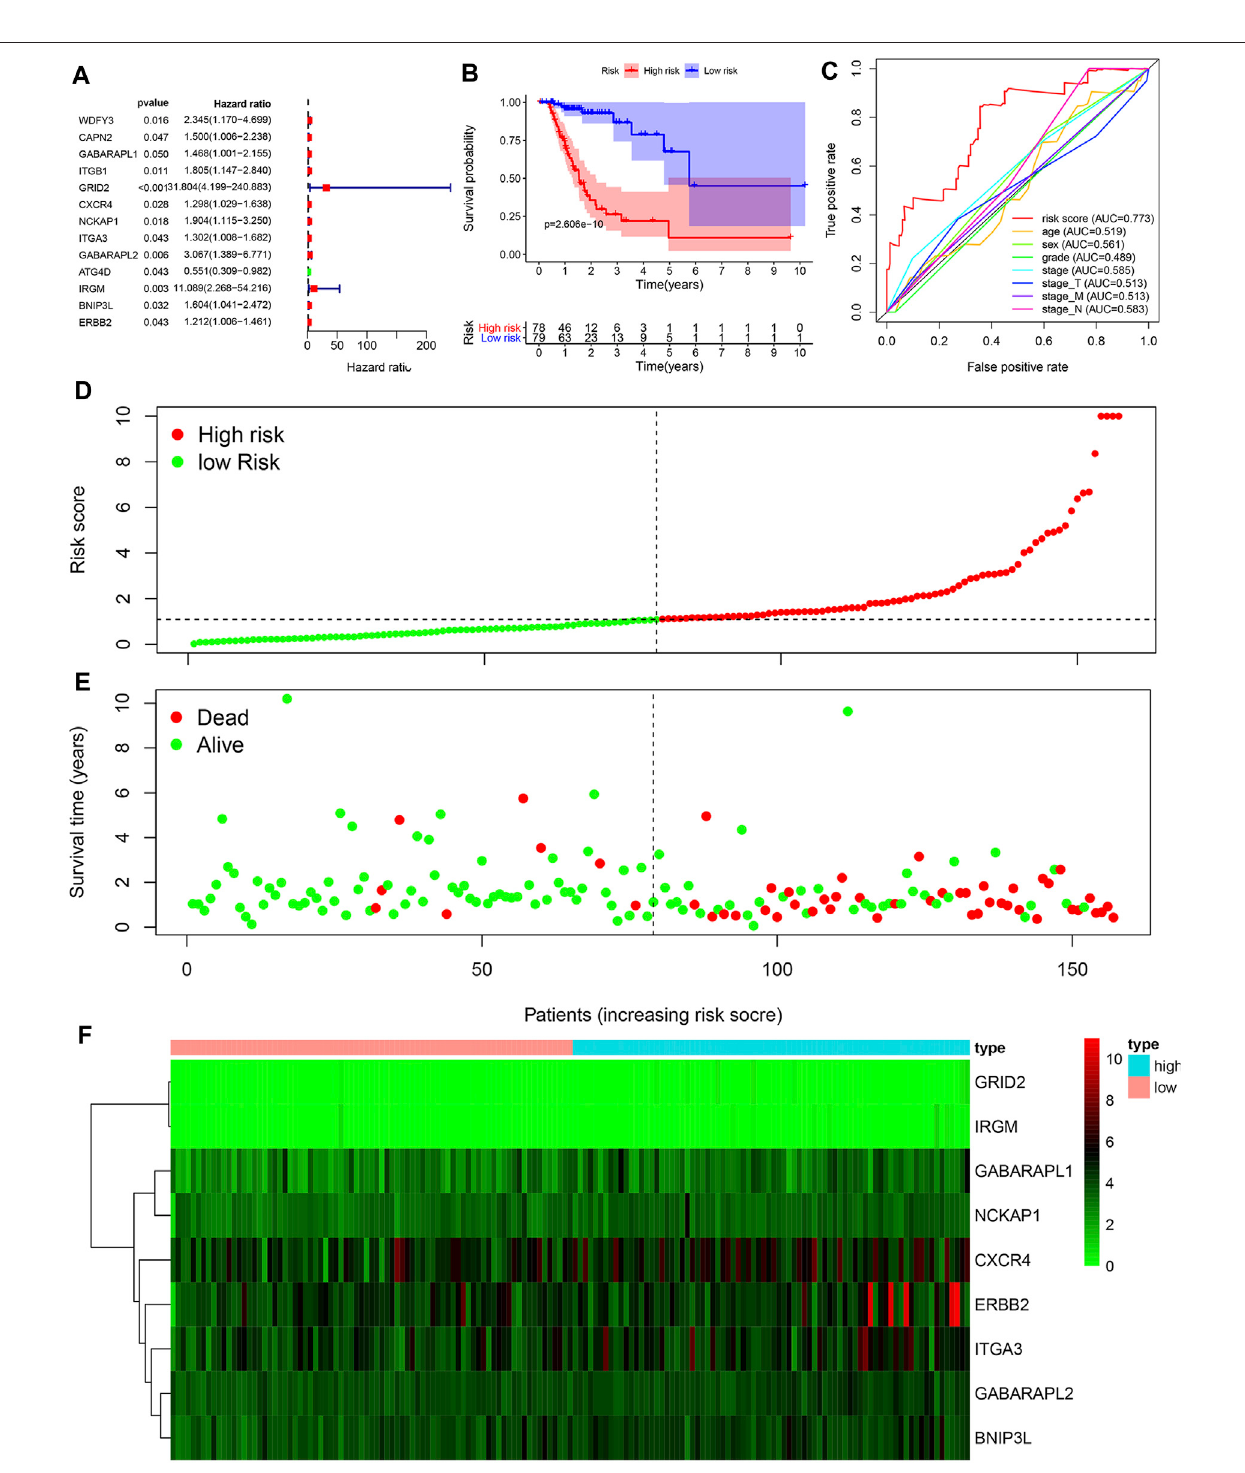
FIGURE 2 | Construction of a prognosis-related risk signature. (A) Univariate Cox regression analysis of ARGs related to overall survival of GC patients with chemotherapy. (B) Kaplan-Meier OS curves for TCGA GC patients treated with chemotherapy by median risk. (C) Multi-index ROC curve of risk score and other indicators. (D) Distribution of the risk scores of GC patients. (E) The number of survivors and non-survivors with different risk scores. (F) The expression of nine ARGs in the high - and low -risk groups.